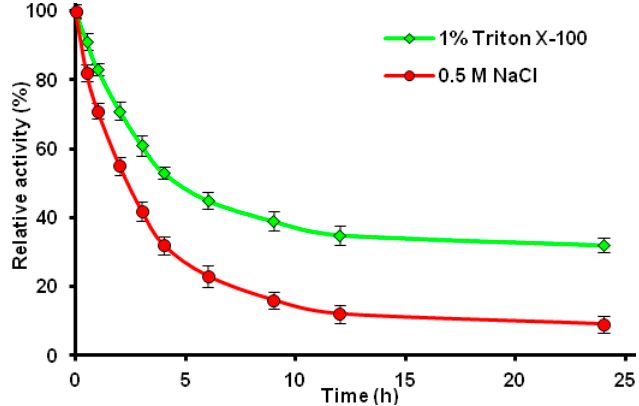
Figure 5. Relative activity of the lipase B from Candida antarctica CALB after desorption from silica ‐ lignin support by 1% Triton X ‐ 100 and 0.5 M NaCl.